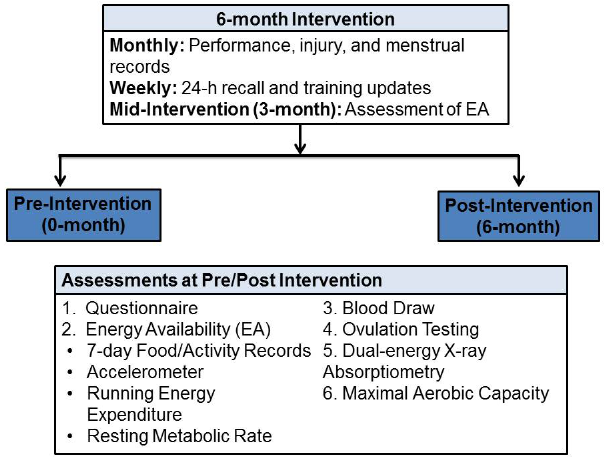
Figure 1. Detailed Protocol of Study: Women with exercise-induced menstrual dysfunction (ExMD, n = 8) were assessed at pre (0-month)/post (6-months)-intervention; a mid-intervention (3-months) assessment was done to monitor compliance. ExMD were compared at pre/post-intervention to a group of Eumenorrheic athletes ( n = 10), who were assessed at 0-month